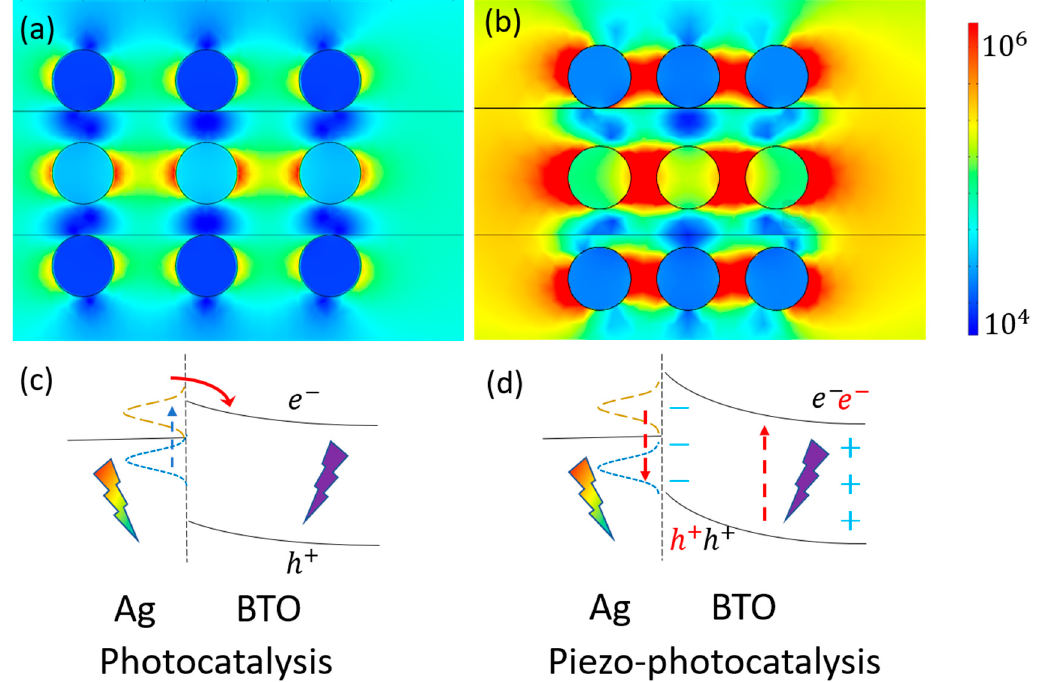
Figure 9. The proposed mechanism of piezo-photocatalysis. ( a , b ) The FEM simulation of the LSPR electromagnetic field of ( a ) Ag-BTO-1 and ( b ) Ag-BTO-2. ( c ) The hot-electron injection process in photocatalysis. ( d ) The PIRET process in piezo-photocatalysis.